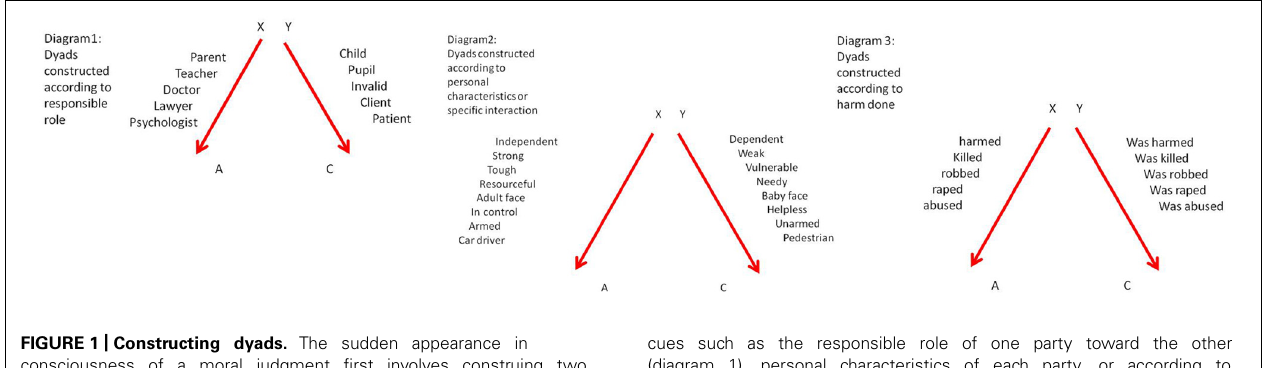
FIGURE 1 | Constructing dyads. The sudden appearance in consciousness of a moral judgment first involves construing two asymmetric parties as child-like (dependent) and adult-like (independent). We construct these categories according to particular